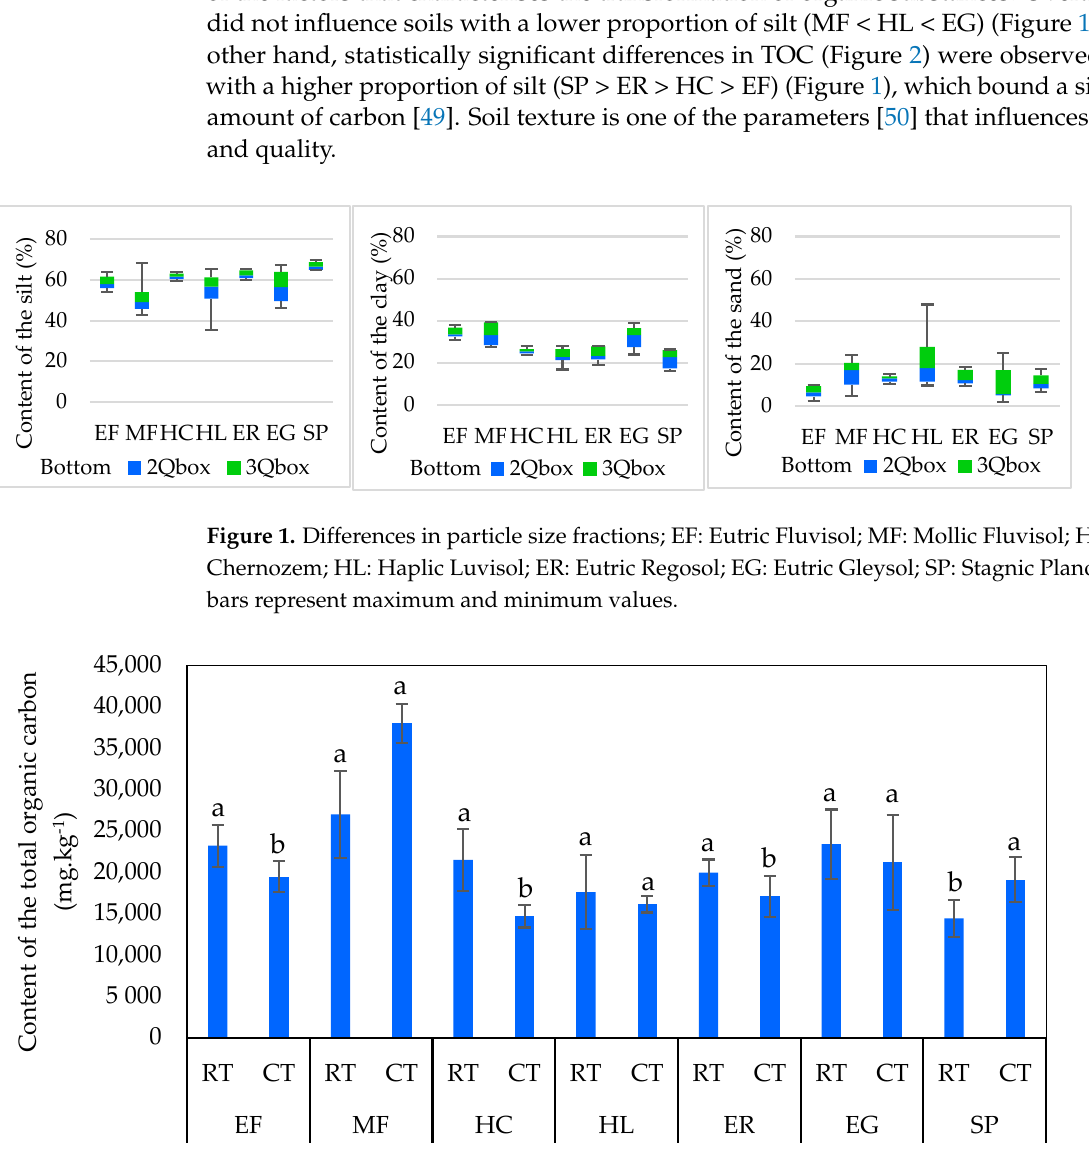
Figure 2. Differences in total organic carbon in the soils. EF: Eutric Fluvisol; MF: Mollic Fluvisol; HC: Haplic Chernozem; HL: Haplic Luvisol; ER: Eutric Regosol; EG: Eutric Gleysol; SP: Stagnic Planosol; RT: reduced tillage; CT: conventional tillage. The different letters (a and b) represent statistically significant differences ( p < 0.05) based on the LSD test.